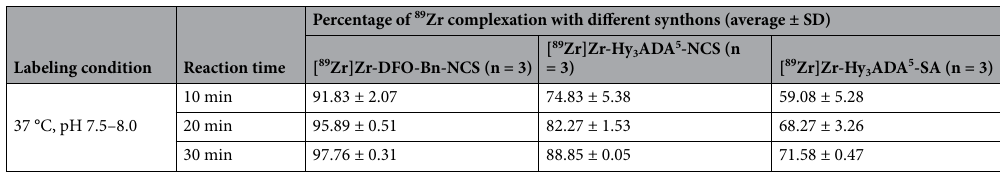
Table 1. Percentage of 89 Zr complexation with DFO-Bn-NCS, Hy 3 ADA 5 -NCS and Hy 3 ADA 5 -SA at different reaction